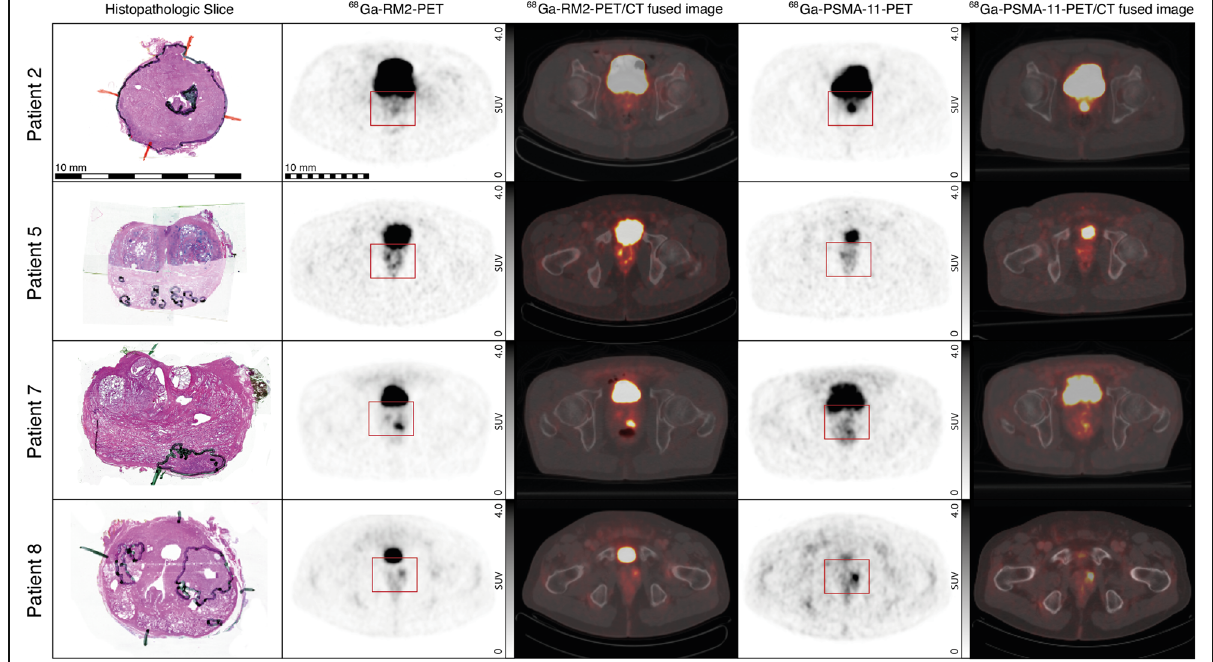
Fig. 1 Corresponding axial slices of histopathologic cut (hematoxylin and eosin stain), [ 68 Ga]Ga-RM2-PET, [ 68 Ga]Ga-RM2-PET/CT fused images, [ 68 Ga]Ga-PSMA-11-PET, and [ 68 Ga]Ga-PSMA-11-PET/CT fused images in four representative patients. Prostate regions on PET images are marked by a red rectangle. Tumor areas in histopathologic cuts are marked with a black line. All histopathologic cuts are scaled identically. Furthermore, all PET and fusion images are also scaled